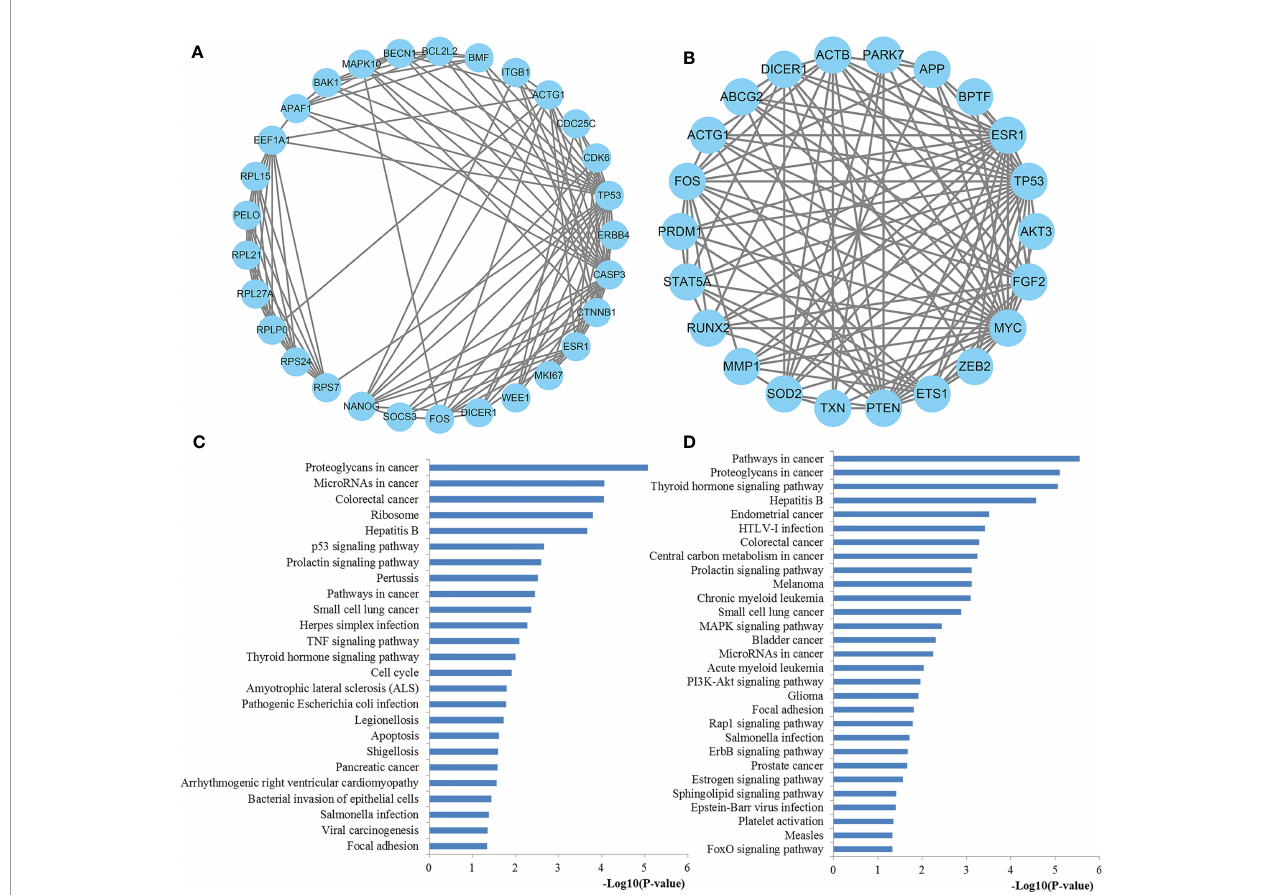
FIGURE 11 | The signi fi cant modules from the PPI network. (A) The signi fi cant module in the PPI network for miR-221 targets; (B) The signi fi cant module in the PPI network for miR-222 targets; (C) Pathways enriched by all the nodes involved in the selected module for miR-221; (D) Pathways enriched by all the nodes involved in the selected module for miR-222. PPI protein – protein